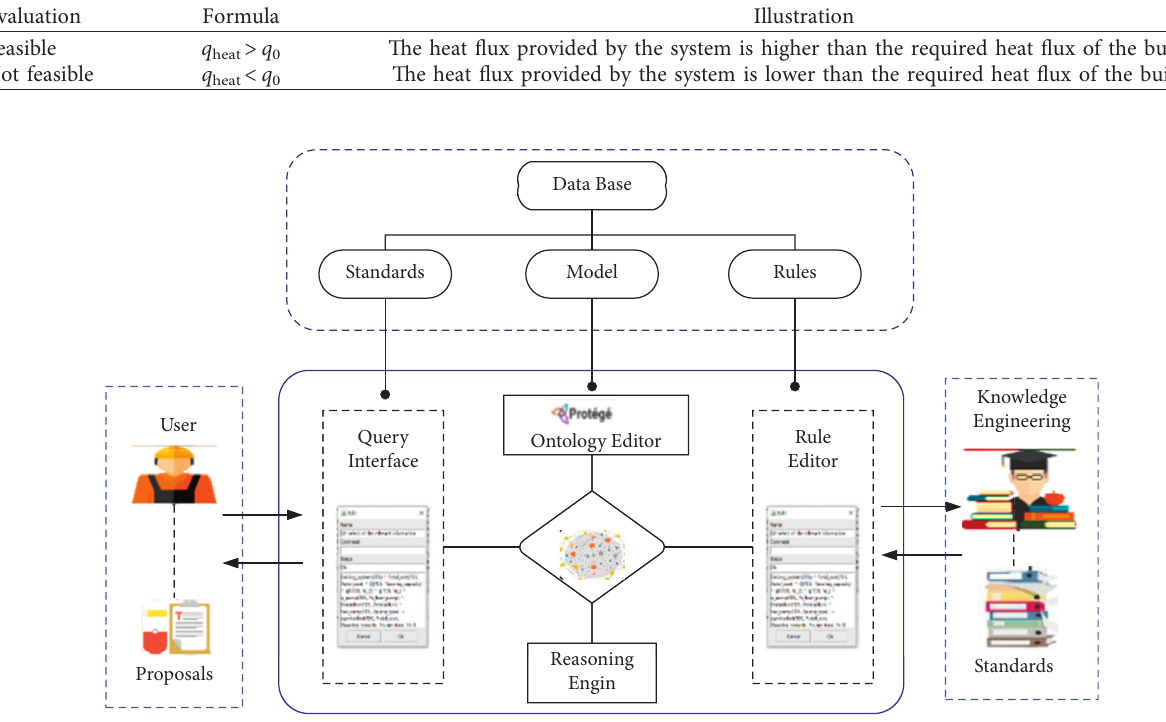
Figure 2: Framework of the OntoETS comprehensive decision-making